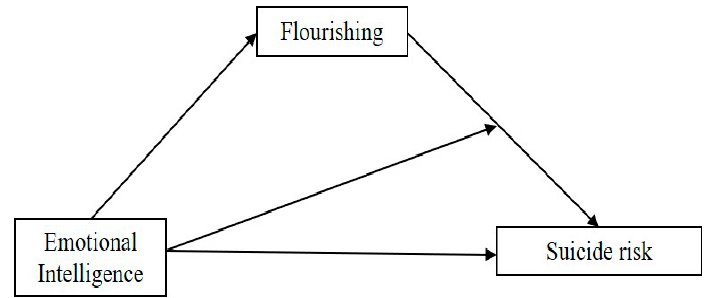
Figure 1. Illustration of the proposed conceptual model.